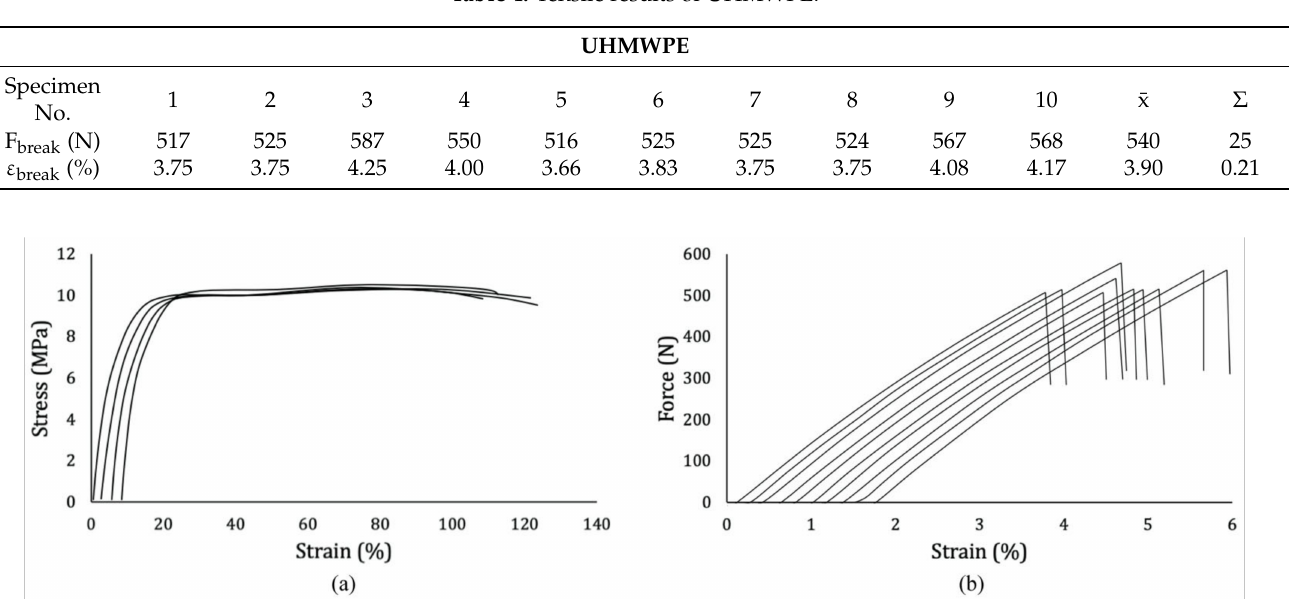
Figure 4. Tensile test results of ( a ) LDPE specimens 1–4 (left to right) and ( b ) UHMWPE yarn specimens 1–10 (left to right), plotted in